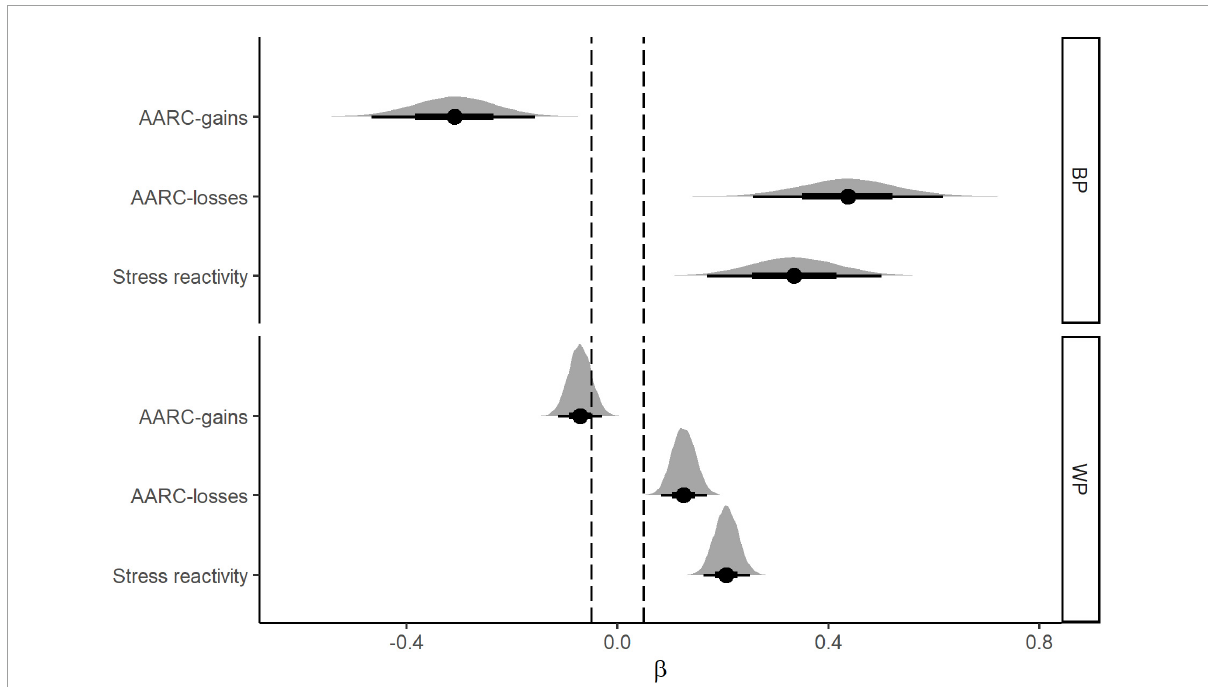
FIGURE1 Between-person (BP, top panel ) and Within-Person (WP, bottom panel ) main effects for AARC and stress severity as predictors of negative affect. The figure shows posterior distributions of coefficient estimates for the main effects and their degree of overlap with the region of practical equivalence (ROPE 0 . 05